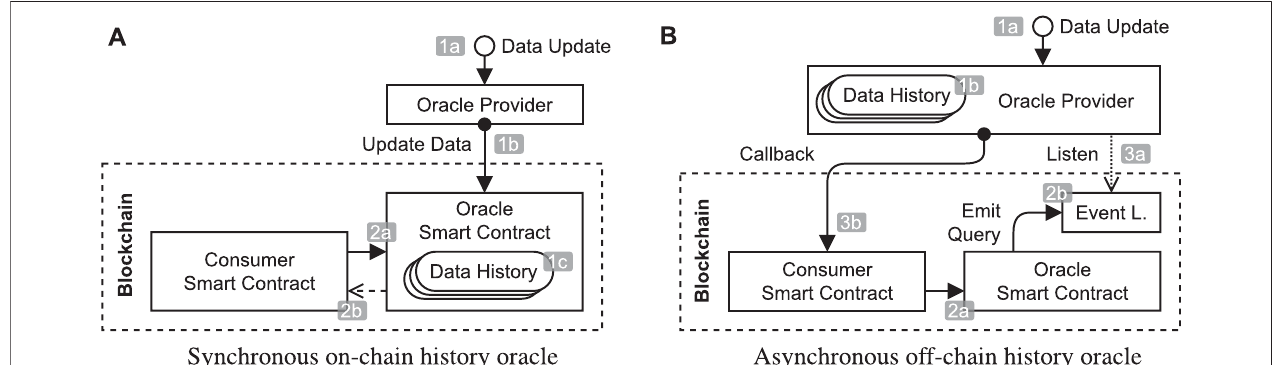
FIGURE 4 | Architecture and behavior of the history oracles.